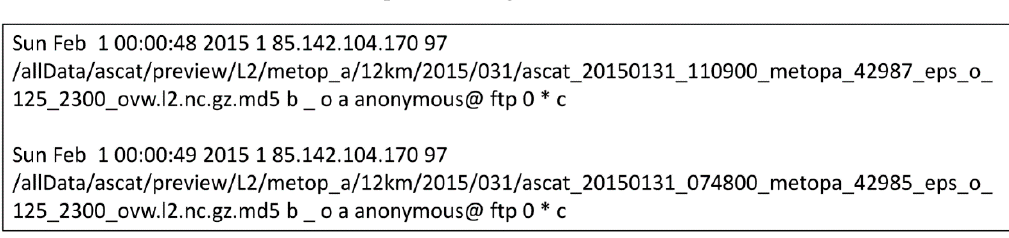
Figure 2. Sample HTTP logs in the combined format.